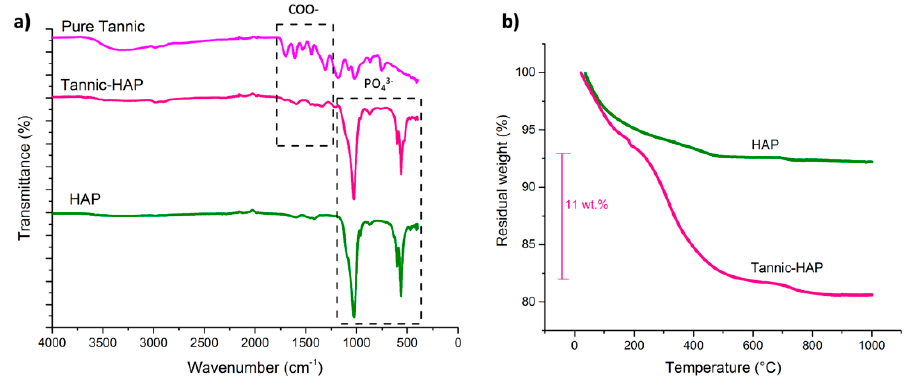
Figure 2. ( a ) FTIR for tannic acid, blank HAP, and tannic acid-loaded HAP; ( b ) TGA for blank HAP, tannic acid, and tannic acid-loaded HAP.